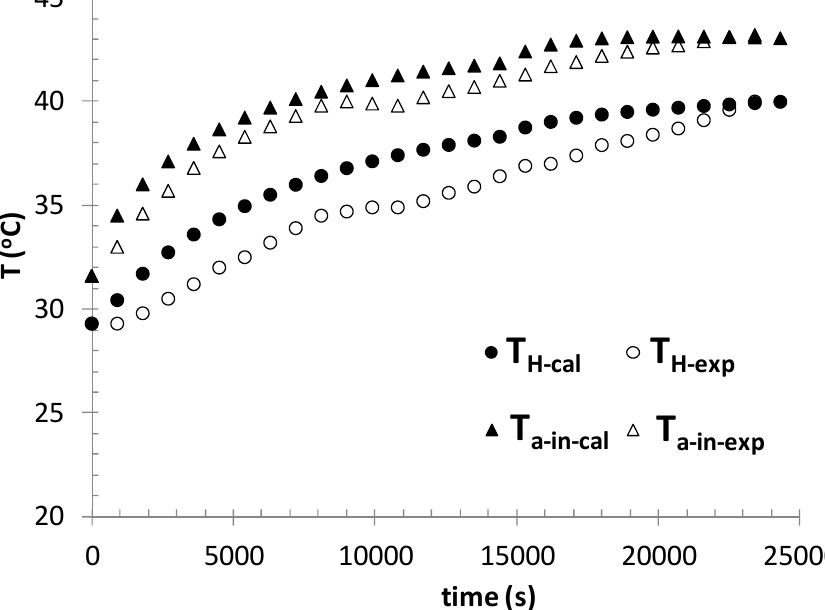
Figure 5. Comparison of the calculated and measured values of the temperature of honey and air, n = 120 rpm, 𝑉(cid:4662) (cid:3028) ≈ 0.024 m 3 s − 1 .